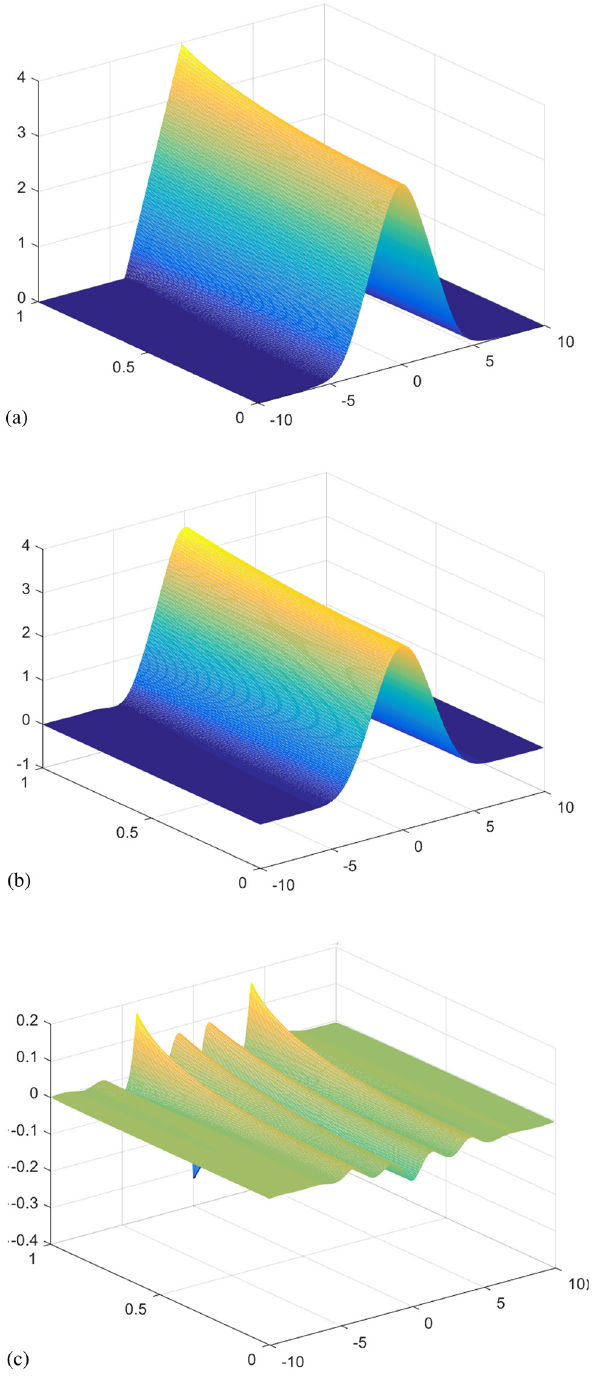
Figure 2: The exact solution, the regularization solution and error for